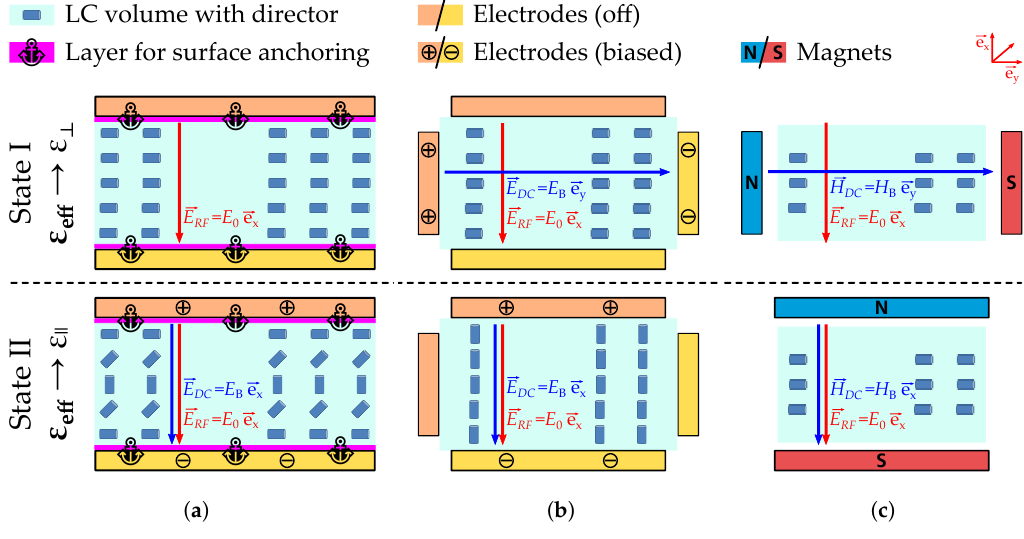
Figure 5. Possible combinations of different orientation mechanisms with state I and II at top and bottom, respectively: ( Left ) combination of surface anchoring and electric actuation as used for planar devices; ( Center ) both electric actuations as used in waveguide components and ( Right ) both magnetic actuations as used for material